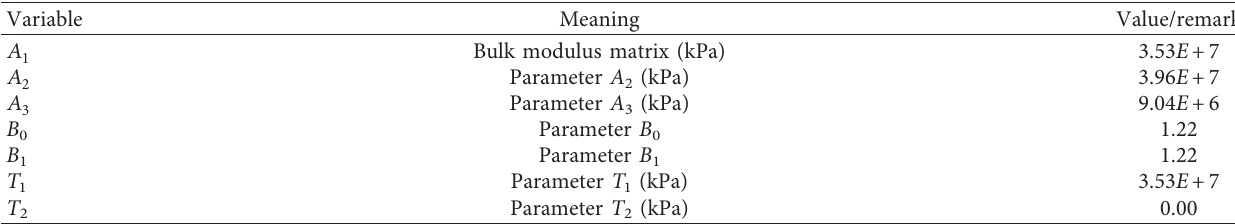
Table 2: Polynomial EOS input parameters for C-35 concrete.